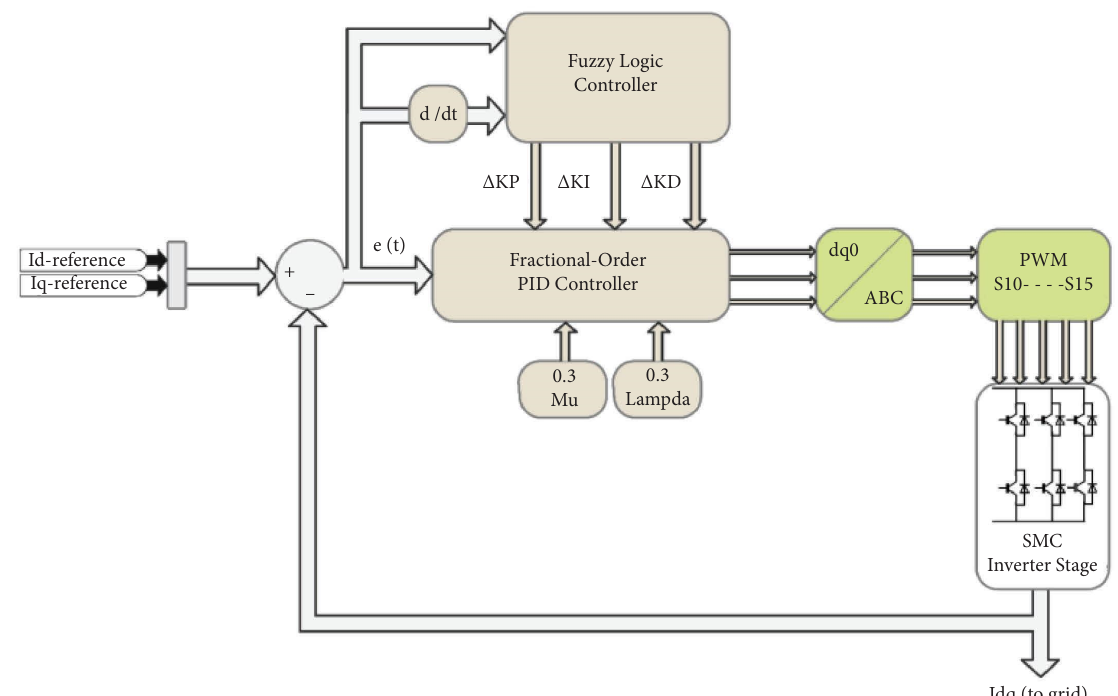
Figure 8: Block diagram of the FFOPID controller.